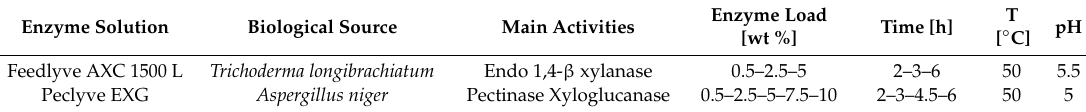
Table 1. Enzyme preparations and summary of all enzymatic treatment